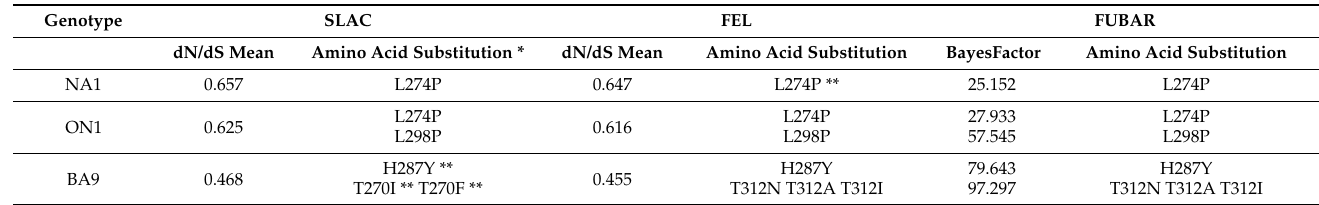
Table 2. Putative sites under positive selection in RSV strains analyzed in